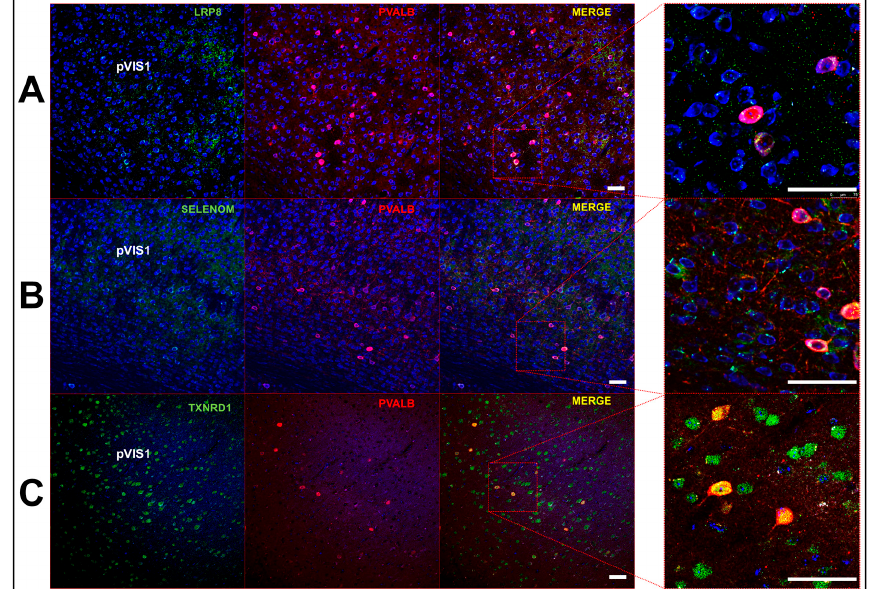
Figure 7. Expression of Se-related proteins in parvalbumin-expressing interneurons (PVIs). ( A ) Confocal images showing expression of LRP8 (left), parvalbumin, (PVALB, middle right) and merged images at low (middle right) and high magnification (right) in the mouse primary visual cortex. ( B , C ) Images depicting expression of SELENOM ( B ) and thioredoxin reductases (TXNRD) ( C ) relative to PVALB. Scale bar = 50 μ m.